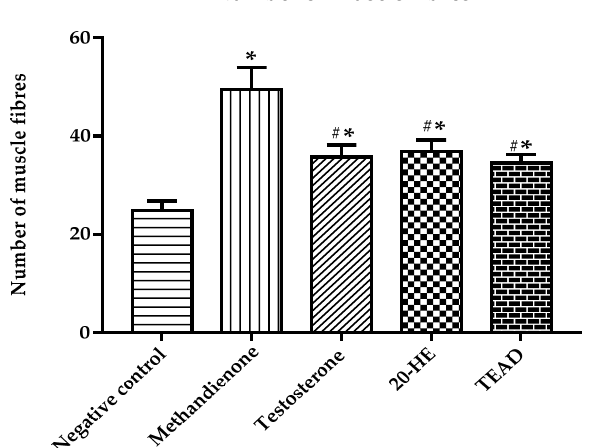
Figure 15. Number of muscle fibers. * : Significantly different from the negative control group at p < 0.0001. # : Significantly different from the methandienone group at p < 0.0001.